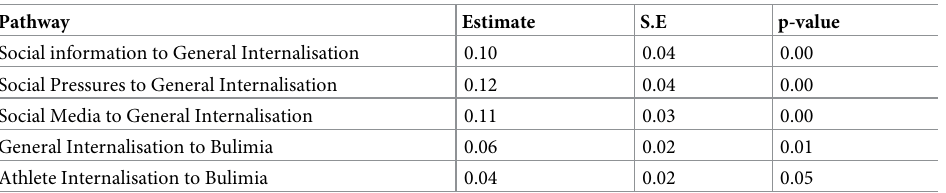
Table 7. Significant pathways in model